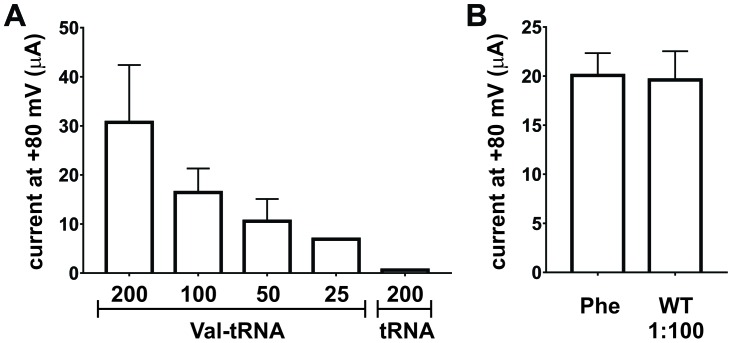
Nonsense suppression efficiency at position E166 in ClC-0.(A) Optimization of tRNA amounts for nonsense suppression of ClC-0 E166TAG. Oocytes were injected with 7.5 ng of ClC-0 E166TAG cRNA and decreasing Val-tRNA amounts (200/100/50/25 ng per oocyte). As negative control non-acylated tRNA (no AA) was coinjected (200 ng per oocyte). Values represent current amplitudes as mean ± s.e.m. (N = 4 for 1; N = 4 for 1/2; N = 3 for 1/4; N = 3 for 1/8; N = 5 for no AA; from 1 batch of oocytes). (B) Injecting a 100-fold dilution of wild-type (WT) ClC-0 cRNA (0.075 ng per oocyte) produced currents at +80 mV similar in amplitude to ClC-0 E166TAG rescued currents with Phe, where 7.5 ng of cRNA was injected per oocyte. Values are shown as mean ± s.e.m. (N = 30 for Phe, N = 5 for WT from at least three independent batches).